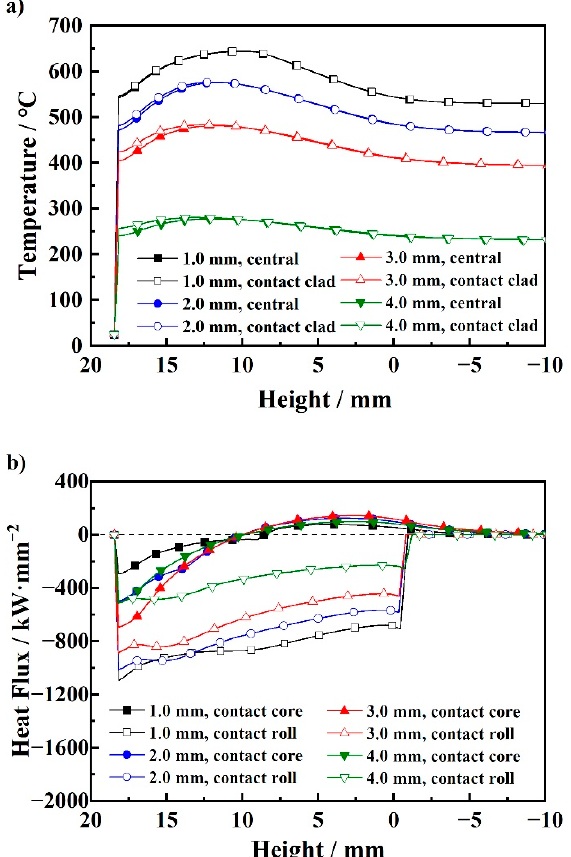
Figure 12. Curves of core temperature and clad heat flux of LSL-TRC with different core thickness. ( a ) Core temperature curves; ( b ) Clad heat flux.